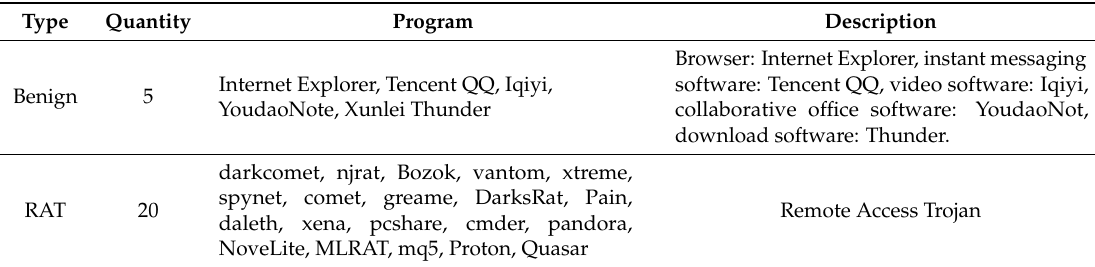
Table 2. Experimental